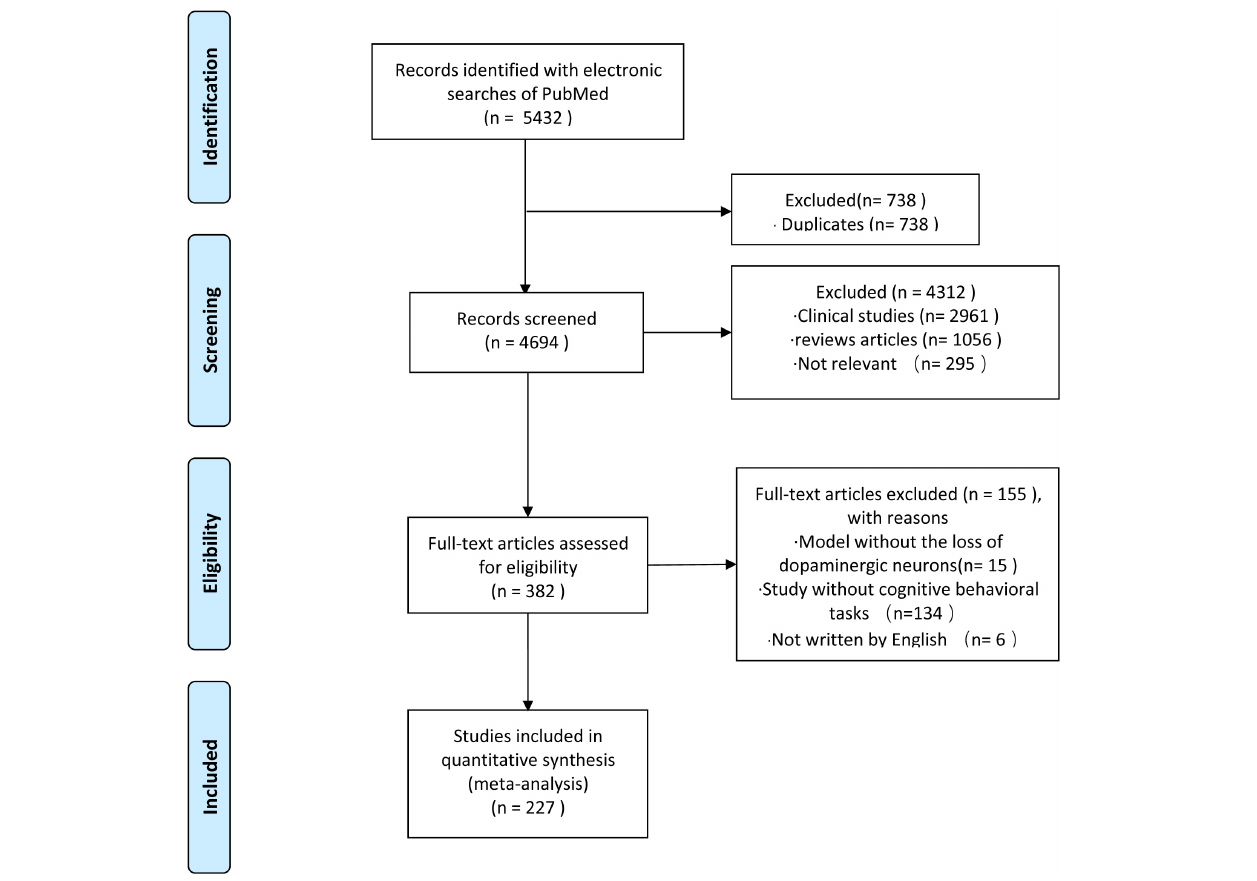
FIGURE 1 | Flow chart for the selection of